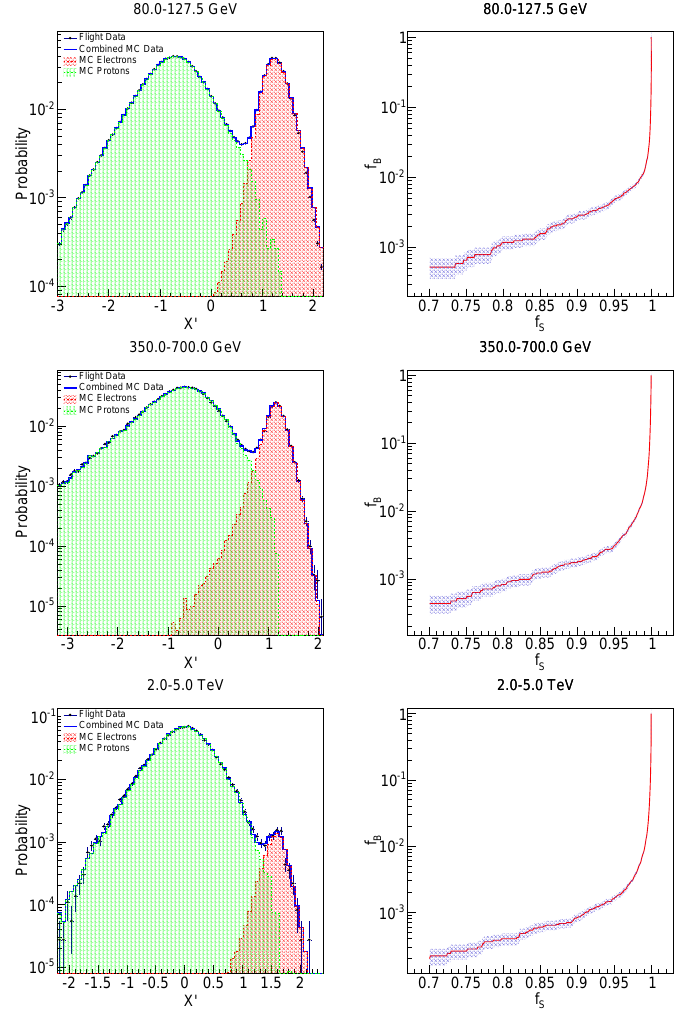
Figure 4. Left: The distributions of the rotated first principal component of the flight data and fitting results of the MC templates (left panels). Right: The residual background fractions versus signal